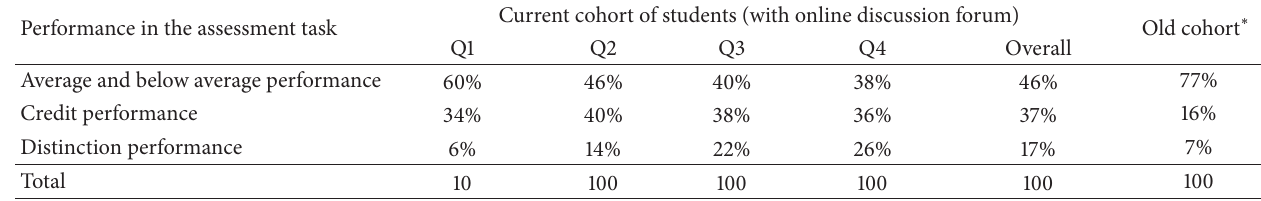
Table 5: Performance in the assessment